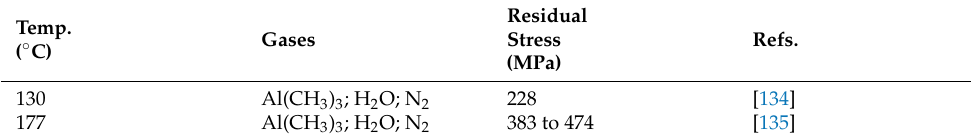
Table 17. Residual Stresses of Al 2 O 3 Deposited using ALD methods.